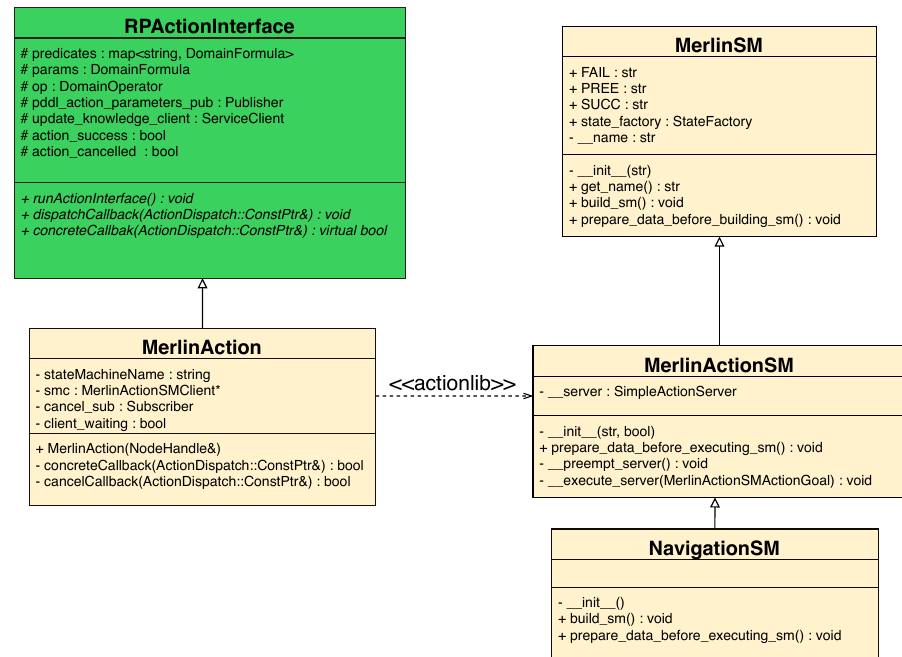
Figure 4. Class Diagram of the Executive